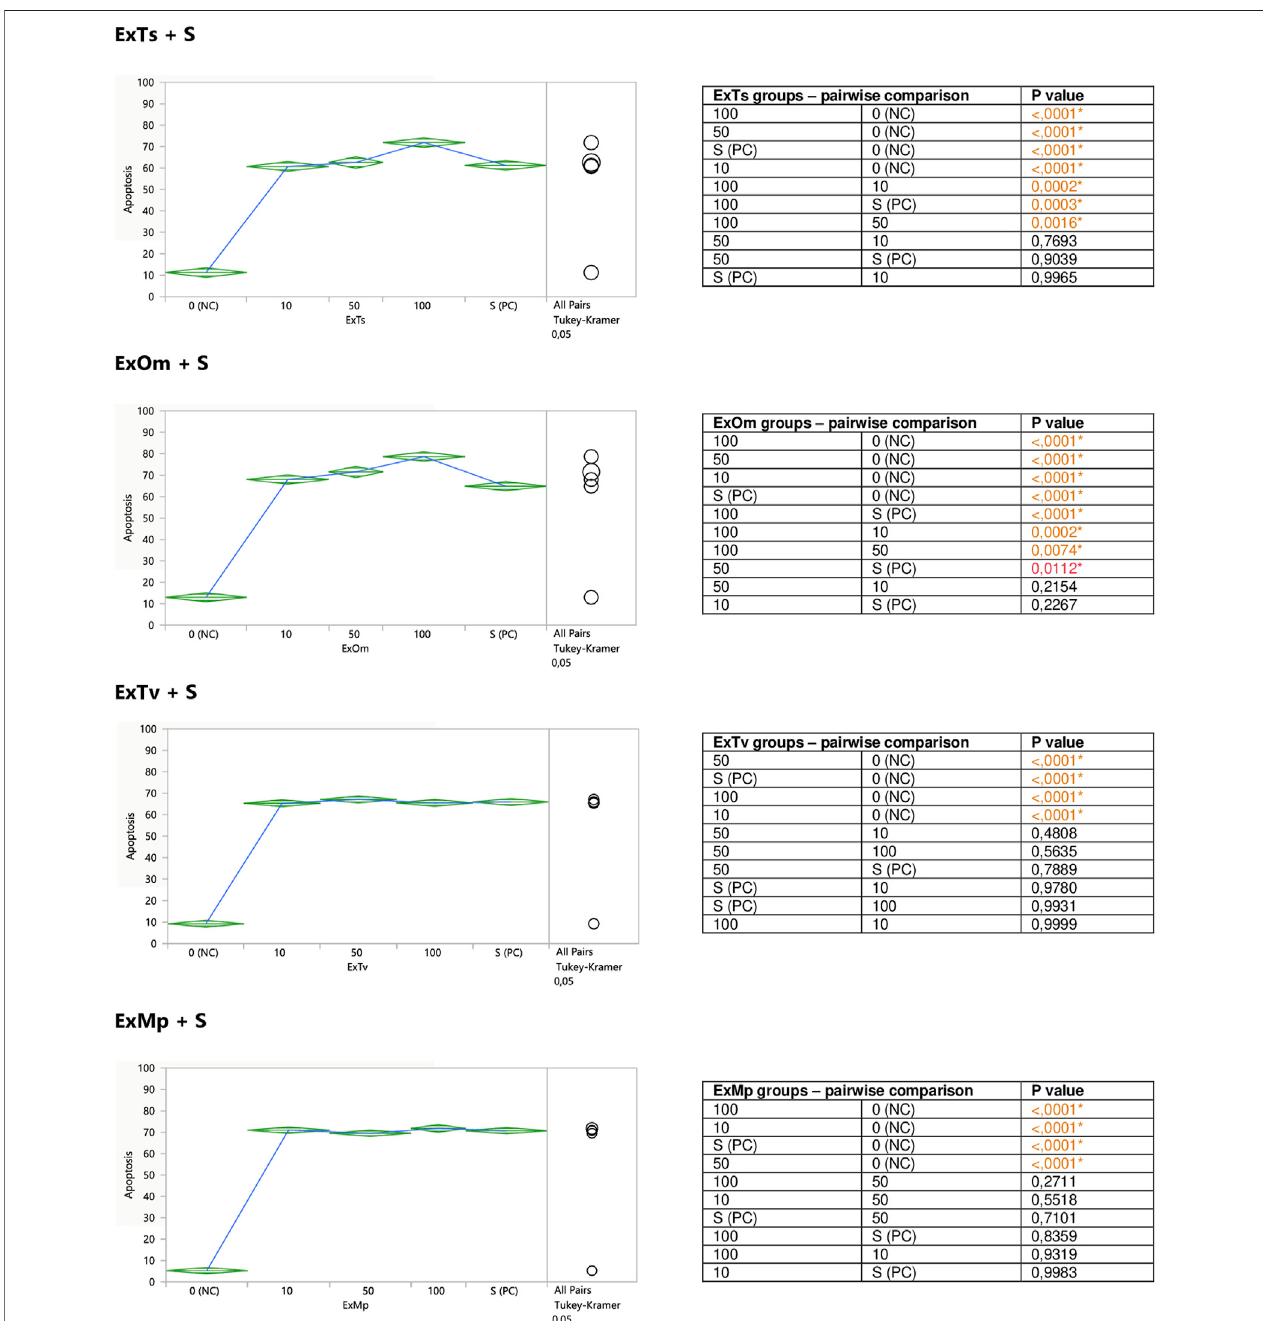
FIGURE 4 | Modulatory effect of ExTv, ExTs, ExOm, and ExMp on staurosporine-induced apoptosis of Jurkat cells. 0 (NC) = negative control (untreated Jurkat cells);S(PC)=positivecontrol(Jurkatcellstreatedwithstaurosporine);10,50,100=Jurkatcellsincubatedwithagivenextractattheconcentrationof10,50,or100 μ g/ ml, and subsequently treated with staurosporine. Apoptosis = percent of apoptotic cells. Means diamonds illustrate ANOVA analysis (upper and bottom points are at 95%con fi dencepointsofeachgroup).Thecirclesontherightexpresssigni fi cantdifferencesbetweengroupmeans(iftheydonotoverlap),orthelackofsigni fi cant differences (if they